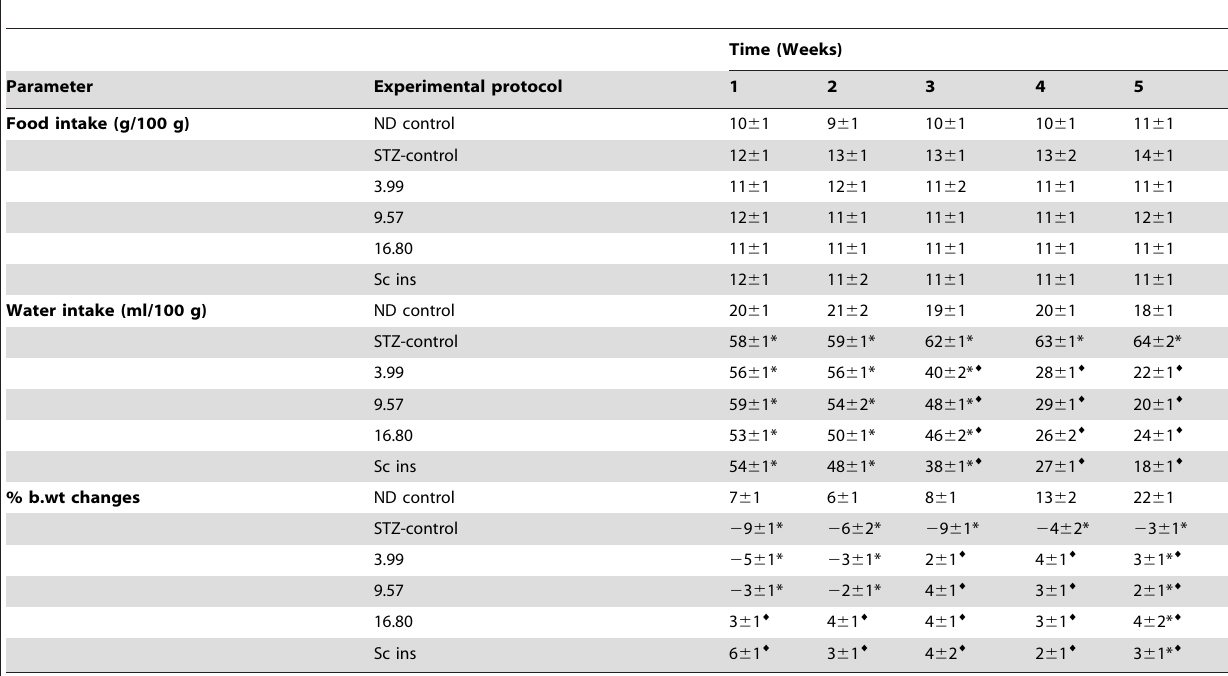
Table 2. Comparisons of the effects of PI matrix patches of different insulin concentrations on body weight, food and water intake in STZ-induced diabetic rats with untreated diabetic rats and control non-diabetic (ND) animals.